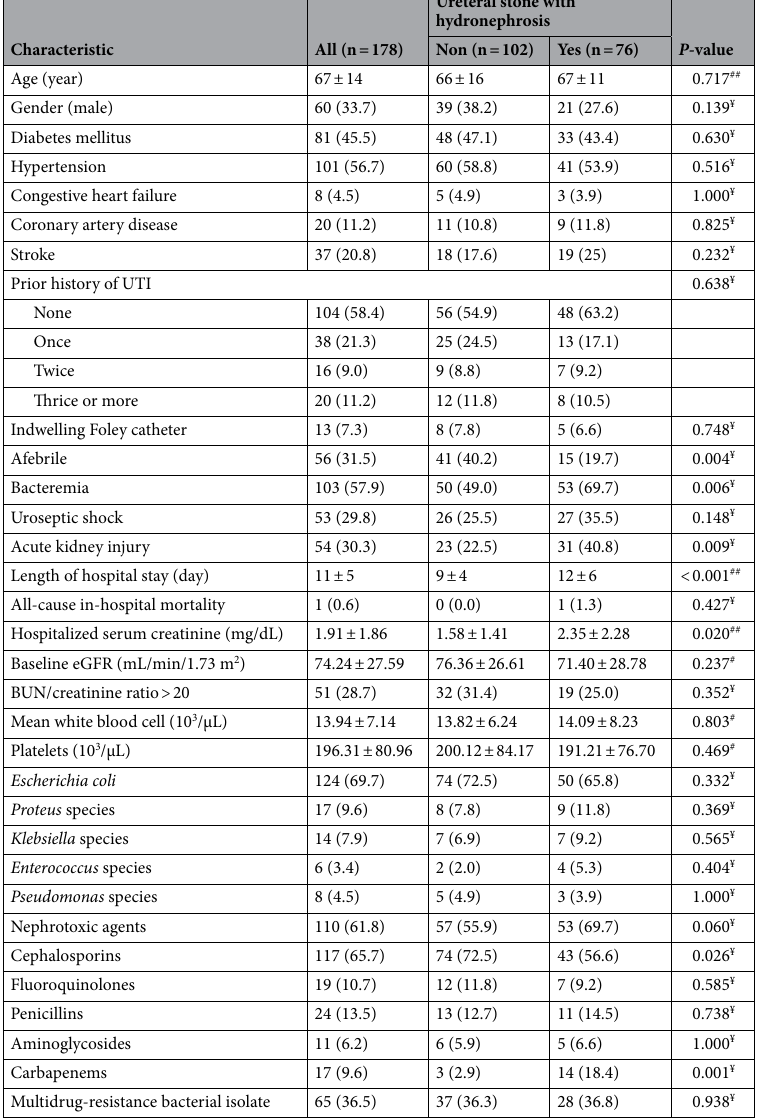
Table 2. Characteristics of hospitalized urinary tract infection patients with urolithiasis with respect to ureteral stone with hydronephrosis. UTI urinary tract infection, eGFR estimated glomerular filtration rate, BUN blood urea nitrogen. Data are expressed as mean ± SD or number (percentage) # Student T-test; ## Mann– Whitney U-test; ¥ Chi-Square test or Fisher’s exact